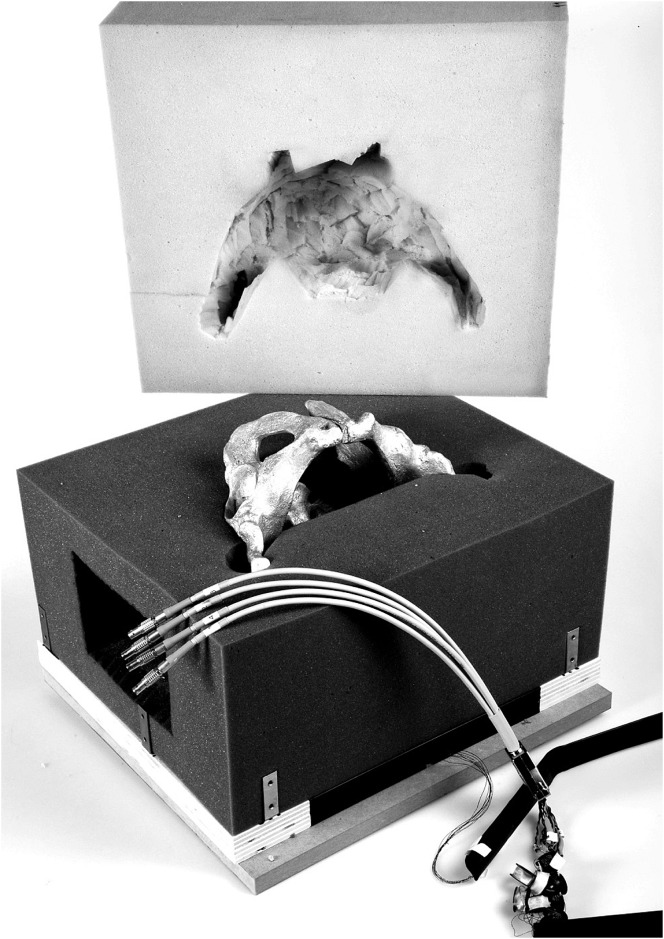
Pelvic model.Illustration of the pelvic model.